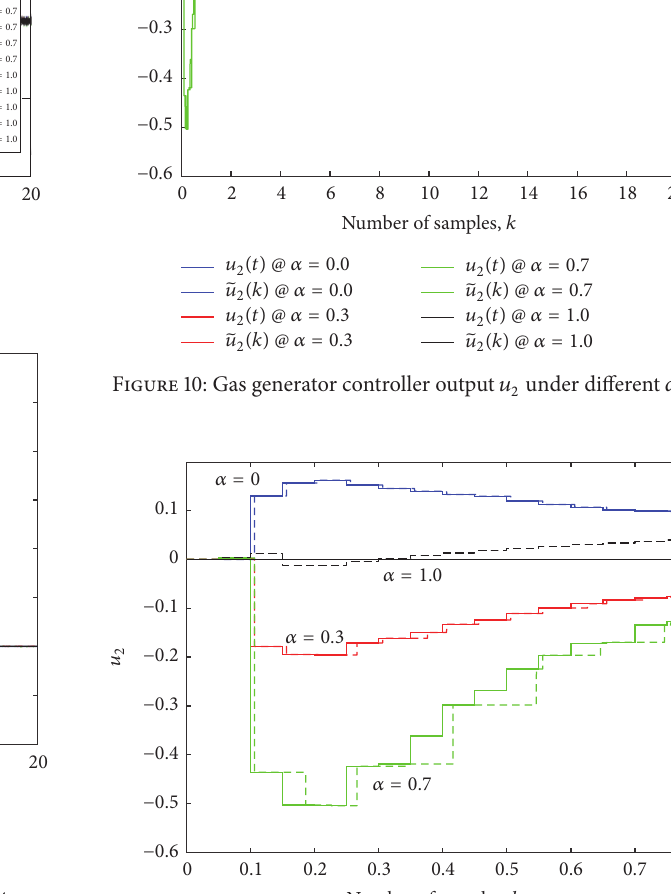
Figure 9: Rotor system controller output 𝑢 1 under different 𝛼 .